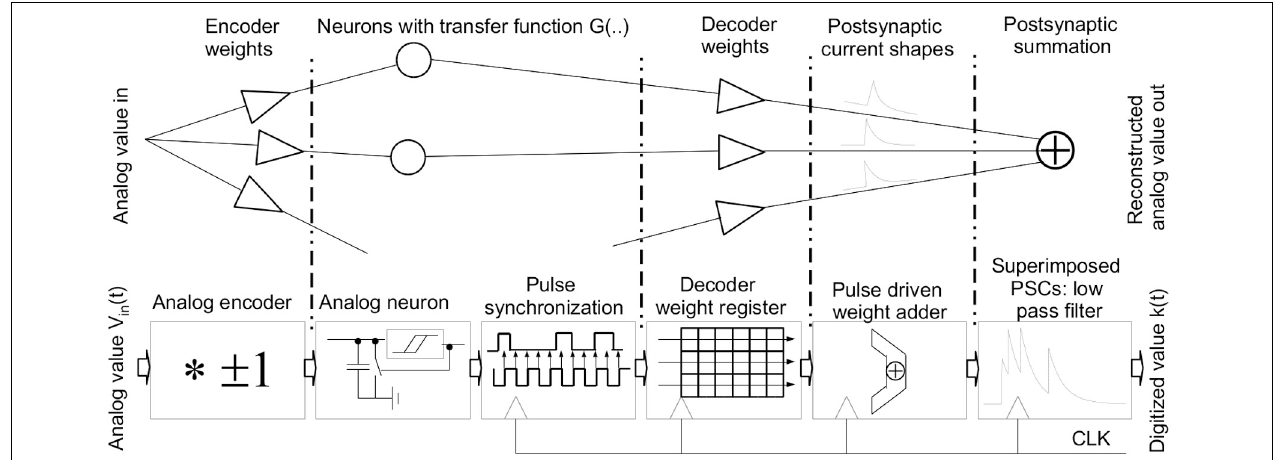
FIGURE 2 | Basic principle of NEF (upper diagram): encoding of an analog value, neuronal representation, decoding and signal reconstruction through an overlay of PSCs; Using NEF as an ADC (lower